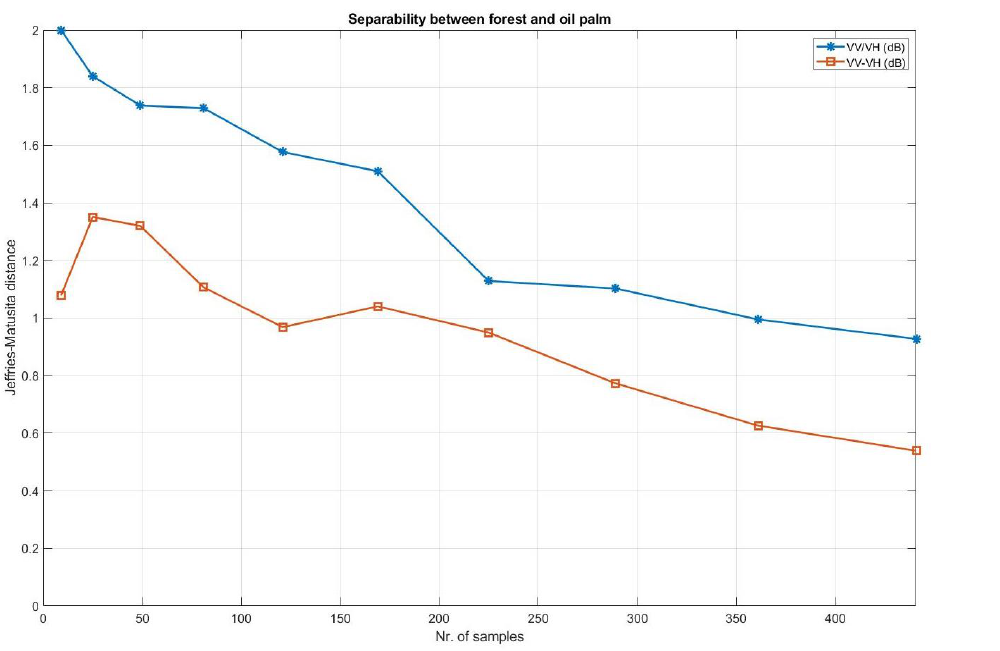
Figure 17. Jeffries–Matusita distance between forest and oil palm classes for the VV/VH ratio and VV–VH difference both expressed in dB for the acquisition in 2021 and F1 and P1 polygons during the wet